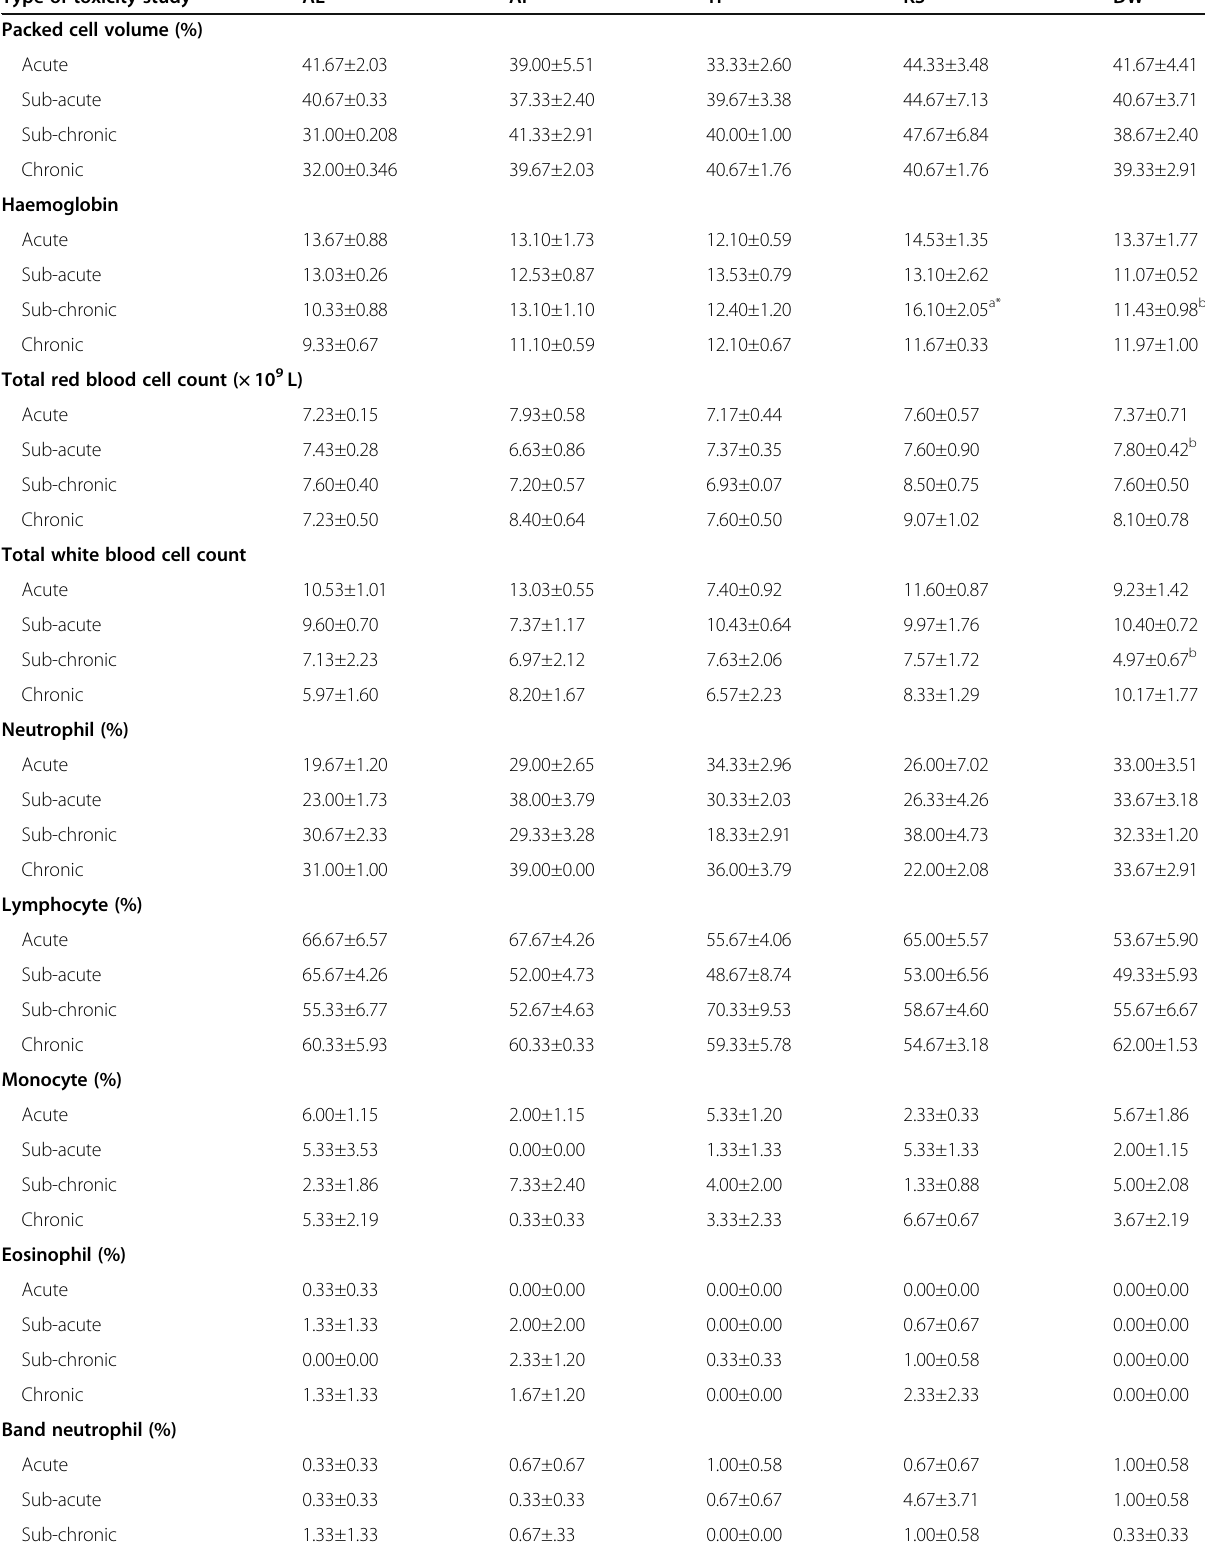
Table 6 Effects of prolonged oral administration of extracts of four ethnomedicinal in rats on blood parameters Type of toxicity